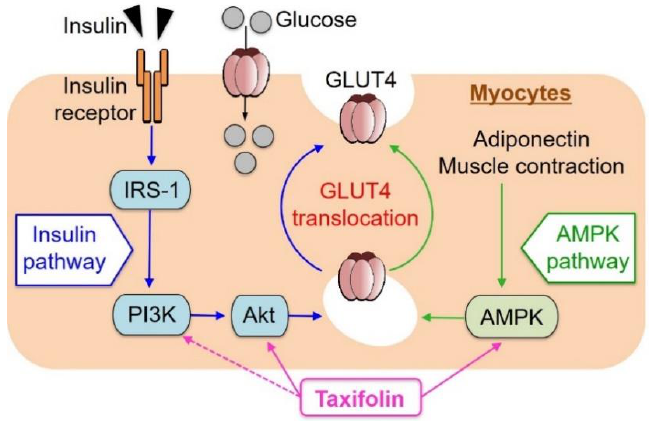
Figure 6. Schematic representation for possible factors involved in glucose uptake by myocytes from extracellular glucose pools.